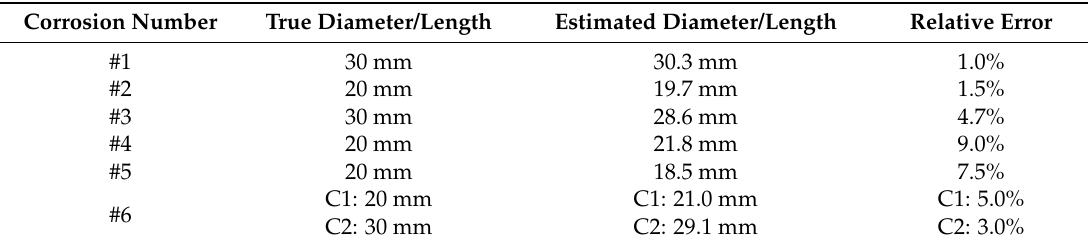
Table 4. Comparison between the estimated corrosion opening size and true